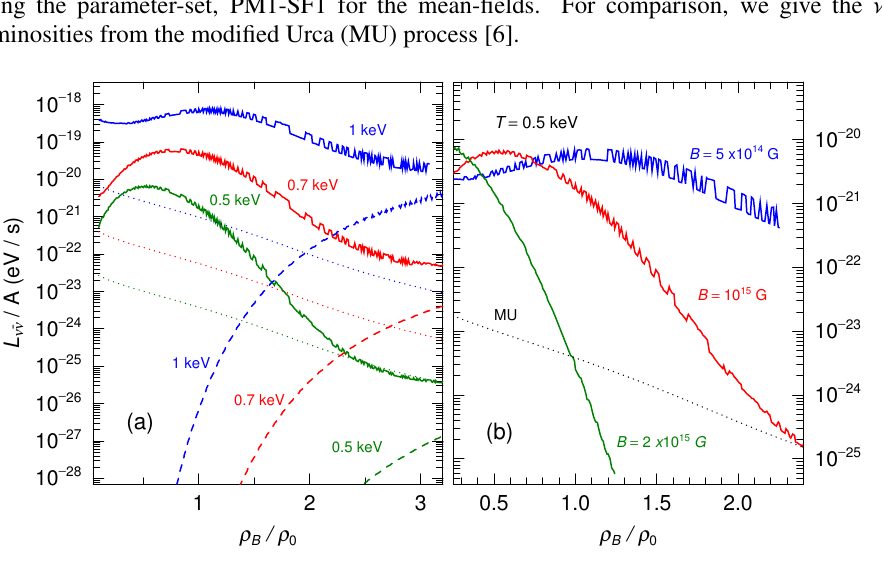
Figure 1. (a) Density dependence of the ν ¯ ν -pair emission luminosity per nucleon. In the left panel (a) The solid and dashed lines represent the contributions from protons and electrons for B = 10 15 G at T = 0 . 5, 0.7 and 1 keV (from bottom to top). The dotted lines indicate the neutrino luminosities from the MU process. In the right panel (b) solid lines show them for B = 5 × 10 14 G, 10 15 G and 2 × 10 15 G at T = 0 . 5 keV. The dotted lines indicate the neutrino luminosity from the MU